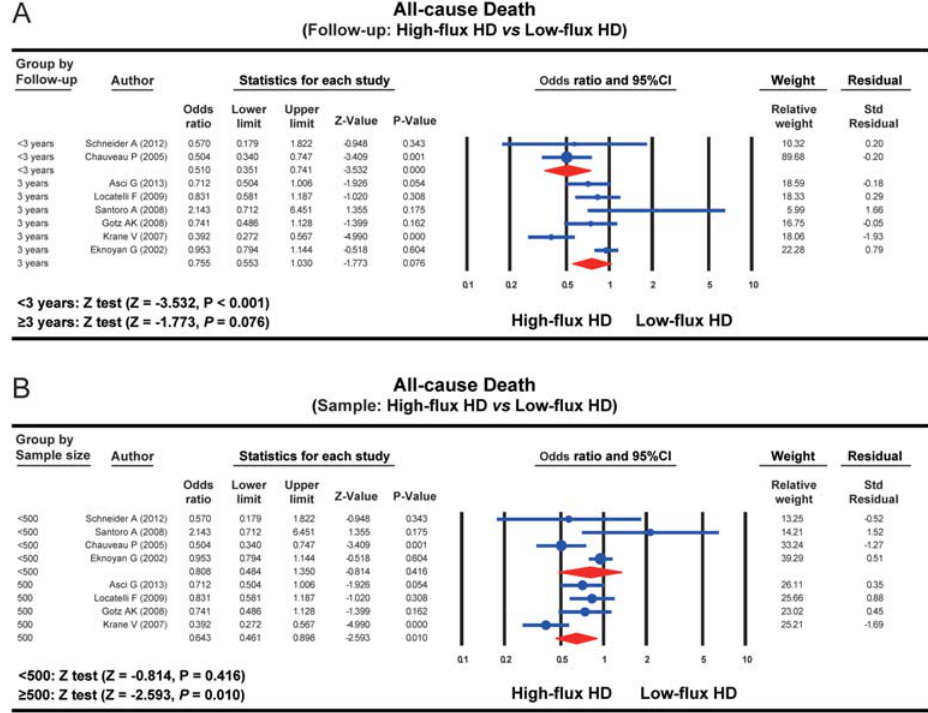
Figure 2. Forest plots of the in fl uence of high- fl ux hemodialysis and low- fl ux hemodialysis on the all-cause death rate of patients with chronic renal disease in subgroup analyses. HD: hemodialysis. See Table 1 for reference numbers.